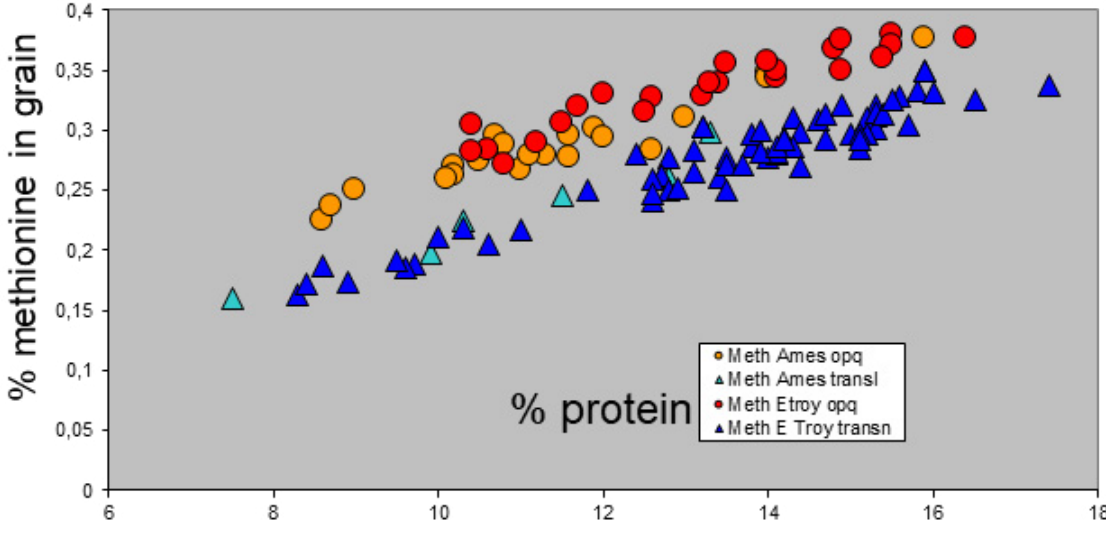
Figure 1: Relationship between protein and methionine content of normal translucent and opaque NG family lines grown in Ames, IA and E. Troy, WI in